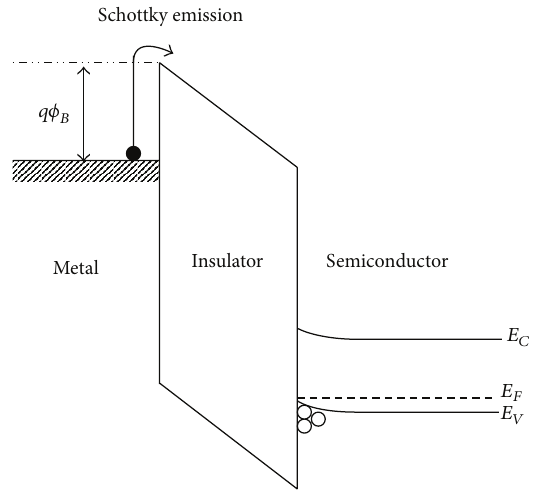
Figure 3: Experimental 𝐽 - 𝐸 curves (symbols) and simulation of Schottky emission (lines) for the Al/CeO 2 / 𝑝 -Si MIS